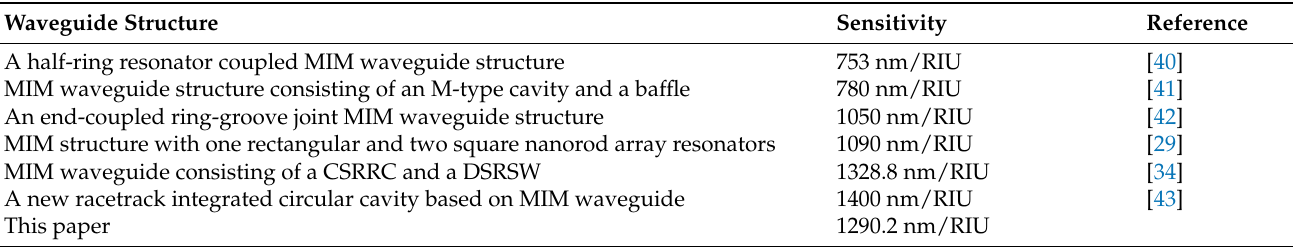
Figure 7. Influences of different SSRC opening directions on the structural Fano resonances ( a ) upper edge and ( b ) all-around. Table 2. Comparison of the sensitivity with other